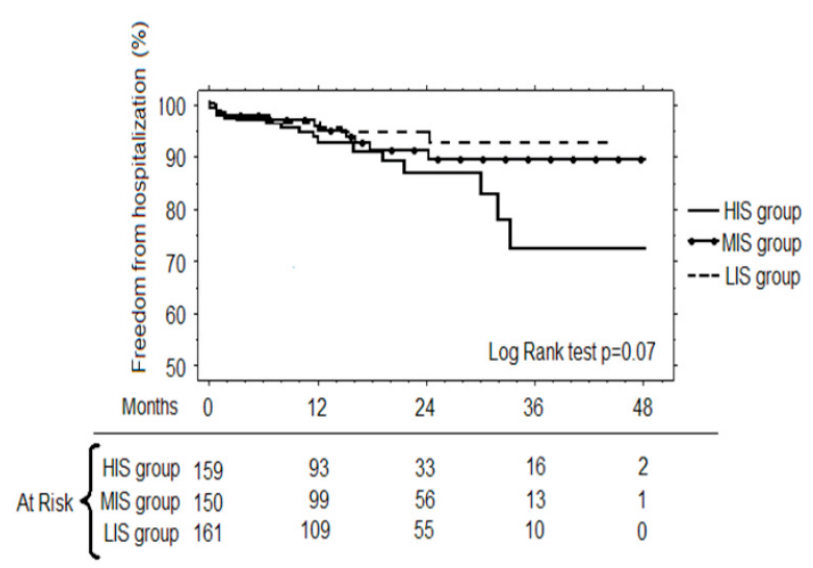
Figure 3. The 48-months freedom from hospitalization for cardiac events for patients of the LIS, MIS and HIS group.